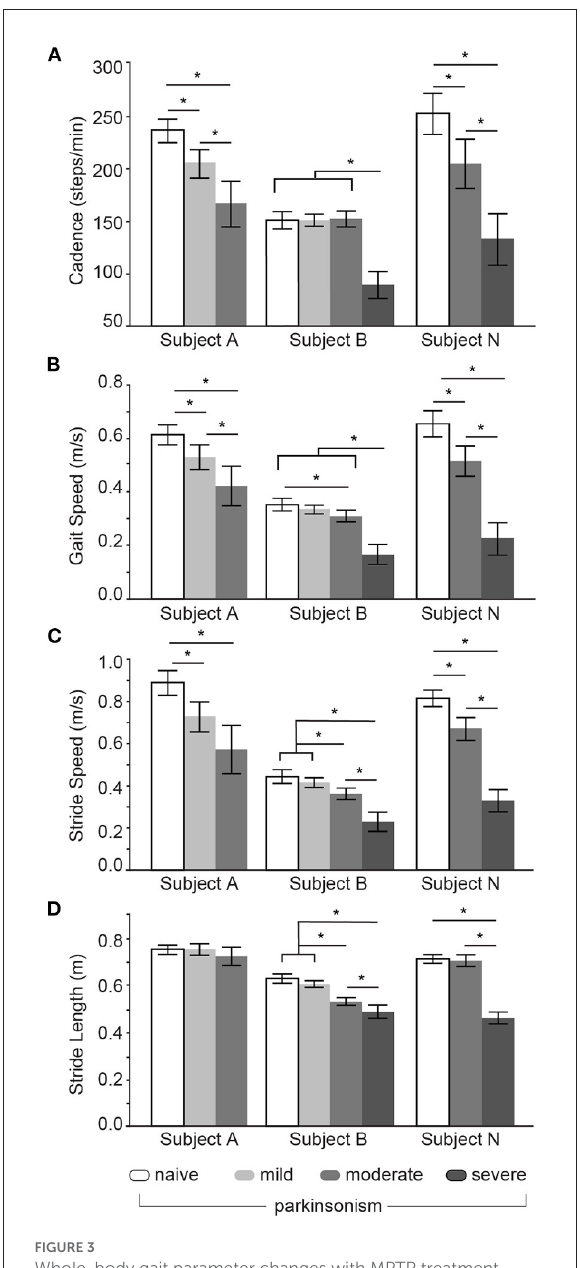
FIGURE3 Whole-body gait parameter changes with MPTP treatment. Means and 95% CI for cadence (A) , gait speed (B) , stride speed (C) , and stride length (D) for subjects A, B, and N across naïve and parkinsonian (mild, moderate, severe) states. *denotes significance at p < 0.05 (statistical results detailed in Tables